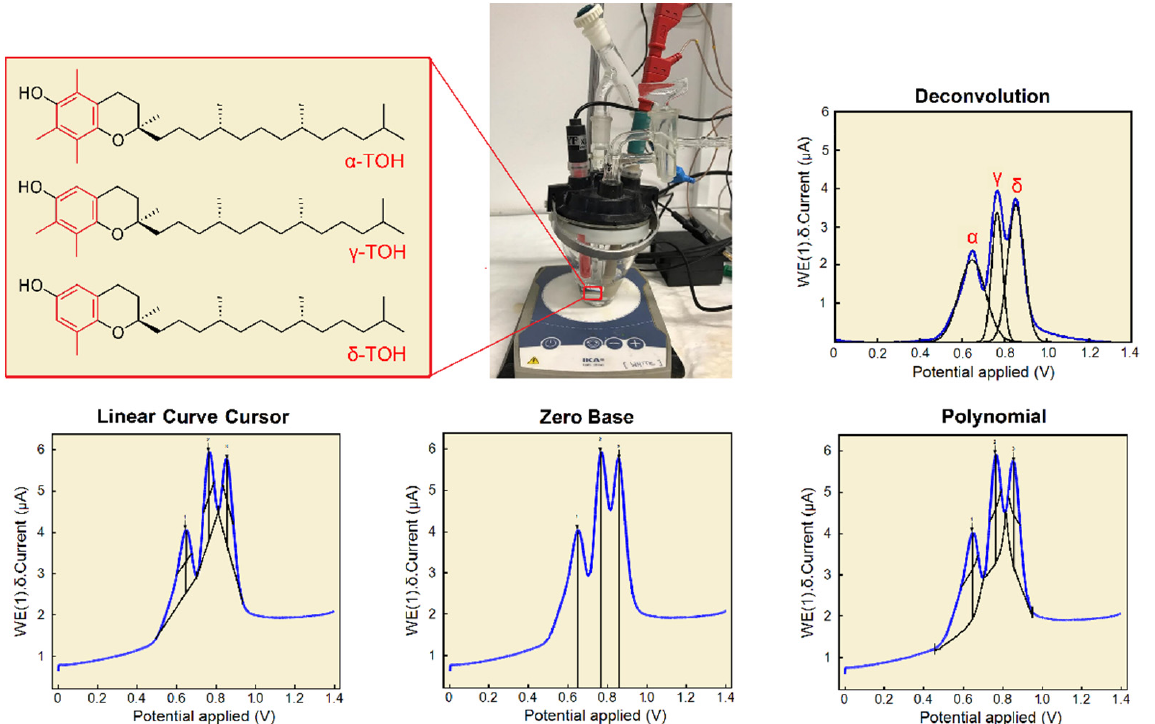
Figure 1. Instrumentation and principles of evaluation methods for simultaneous electrochemical detection of different tocopherols.